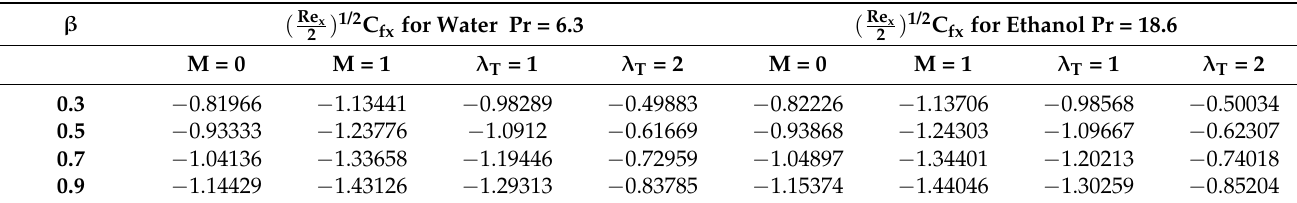
Table 1. Skin friction C fx for different values when λ M = N t = 0.5. β